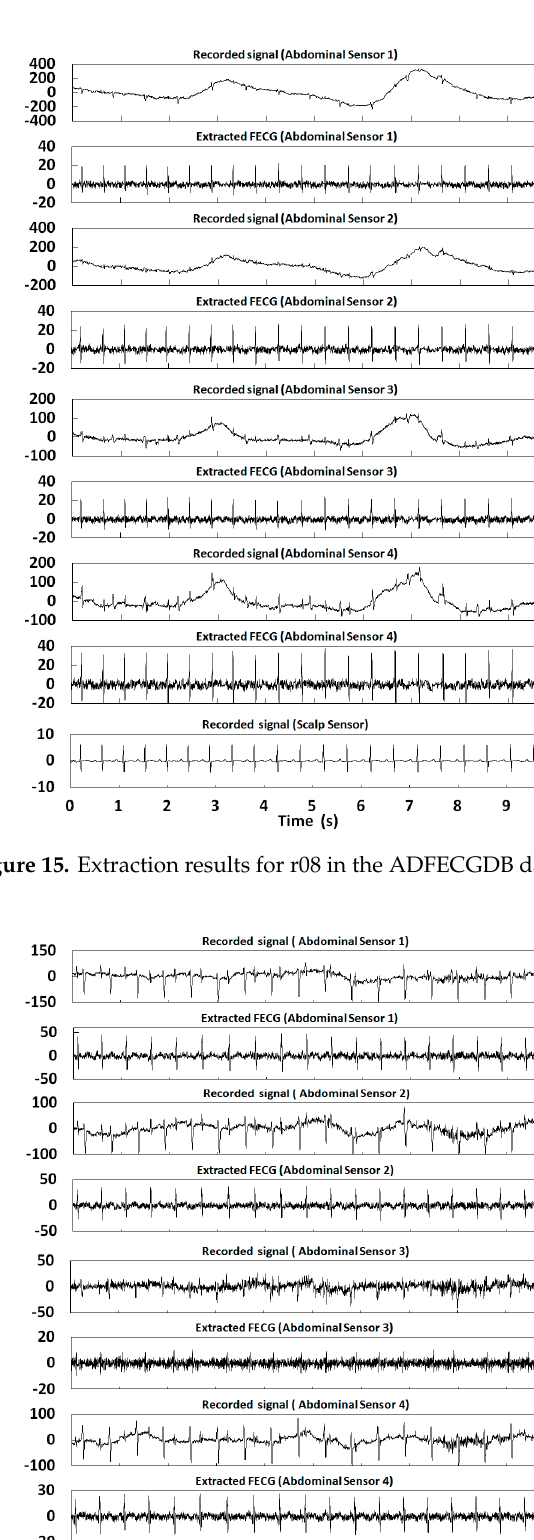
Figure 14. Extraction results for r07 in the ADFECGDB database.